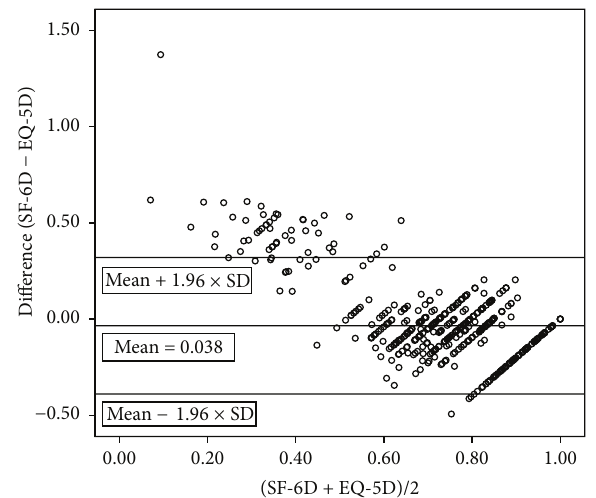
Figure 1: Bland-Altman plot of the differences in utility scores between SF-6D and